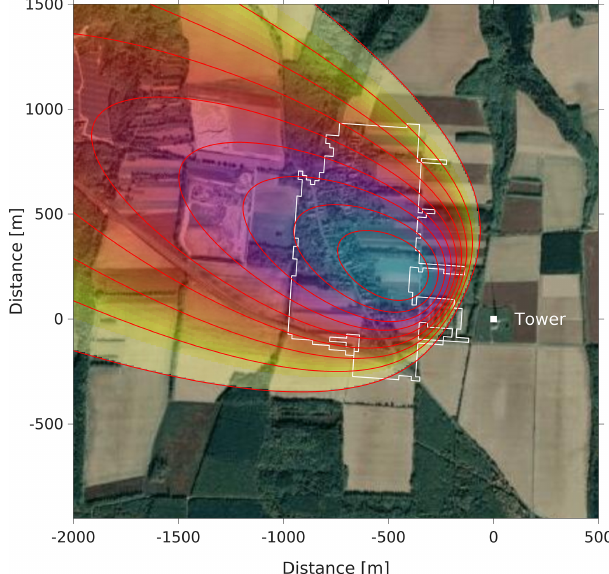
Figure 6. Example of a single flux footprint (10:00–11:00LST, 27 December 2016). The footprint contour lines (red) show a 10%– 90% contribution to the flux measurement in 10% steps. The inte- gral of the footprint function over the village ( α , outlined in white) is 0.282 for this case (map source: © Google Earth).